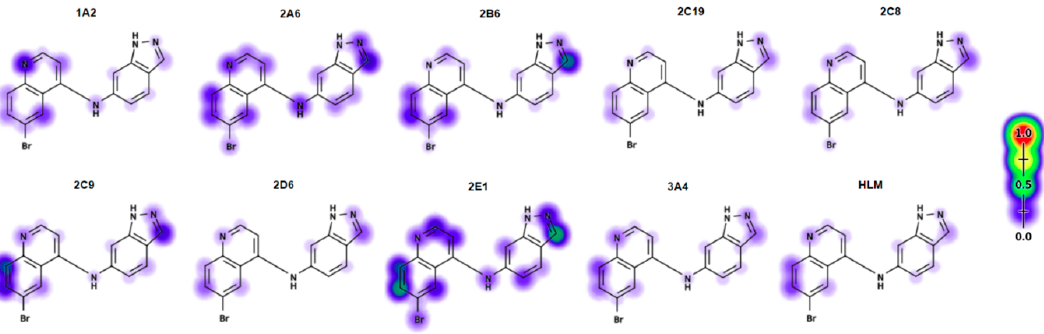
Figure 12. Compound 35 in XenoSite’s P450 Metabolism P450 1.0 algorithm.